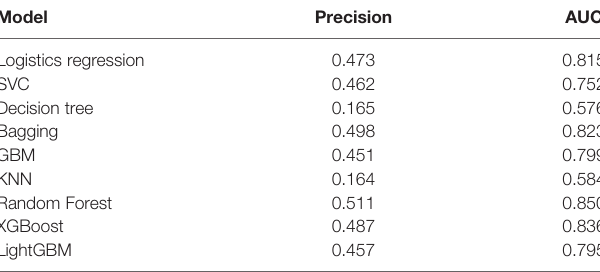
TABLE 2 | Comparisons of nine different machine learning models.